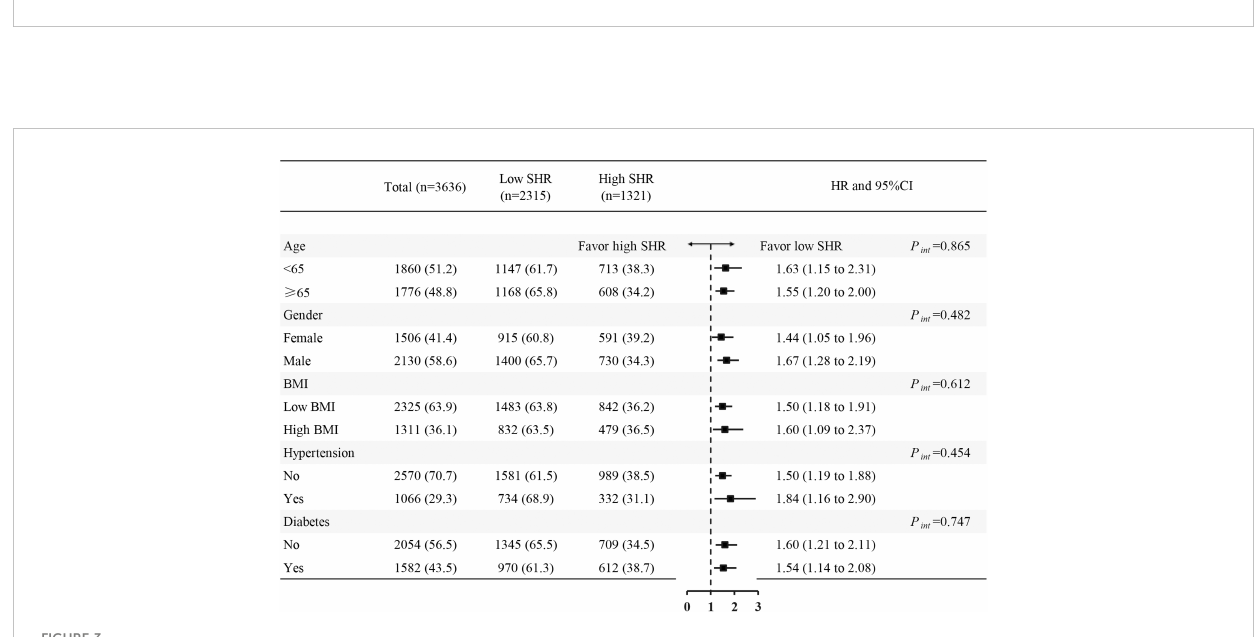
FIGURE 2 Association between the 1-year all-cause mortality and SHR (A) Kaplan-Meier survival analysis curves for all-cause mortality according to low SHR group and high SHR group at 1 year; (B) Survival curves according to low SHR group and high SHR group in the Cox proportional hazards model after adjustment for age, gender, hypertension, diabetes, COPD, and CKD. SHR, stress hyperglycemia ratio; COPD, chronic obstructive pulmonary disease; CKD, chronic kidney